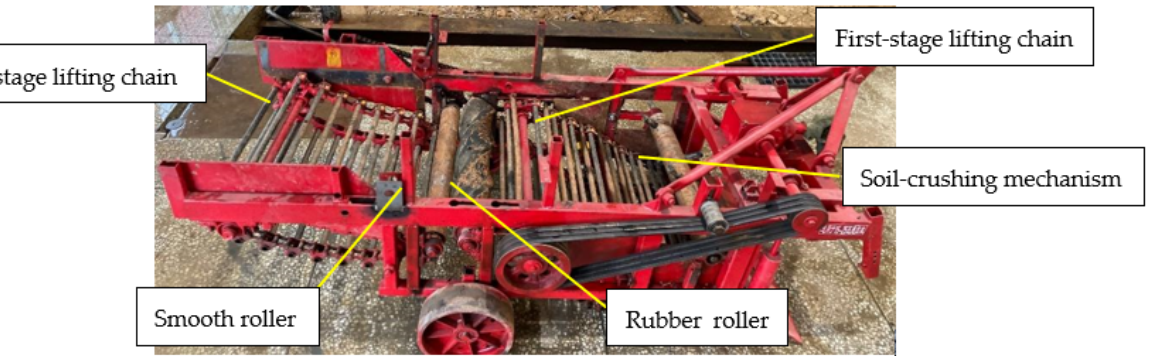
Figure 9. Test prototype of potato-soil separation device.